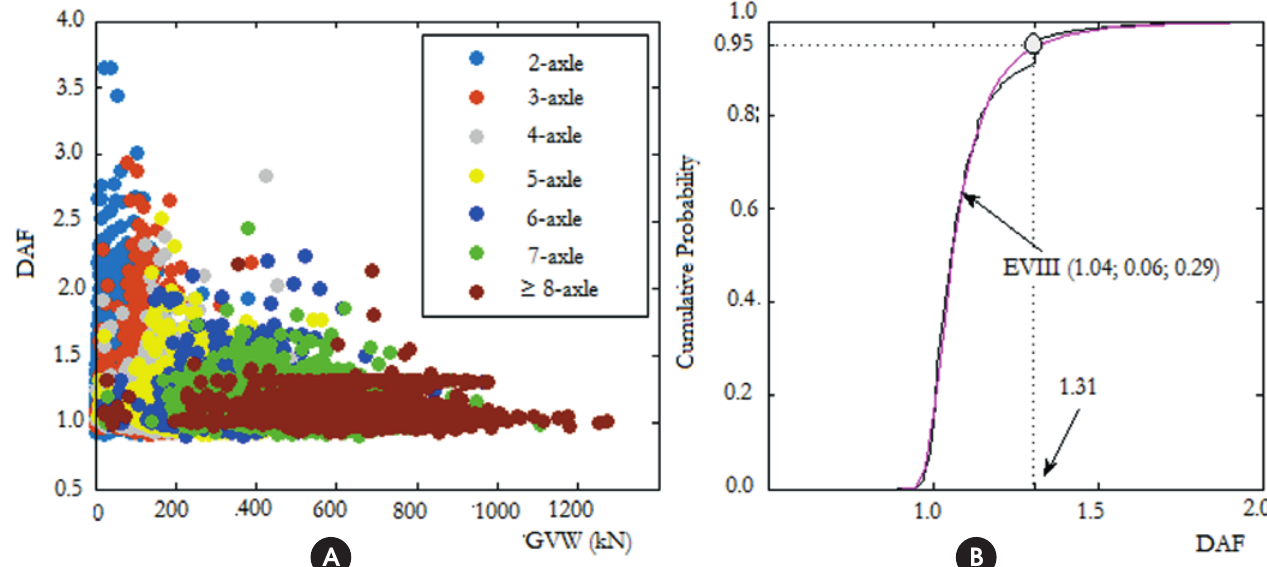
BB (a) Dynamic amplification factor (DAF) by vehicle type and (b) fitting a Fréchet function to the cumulative probability of DAF